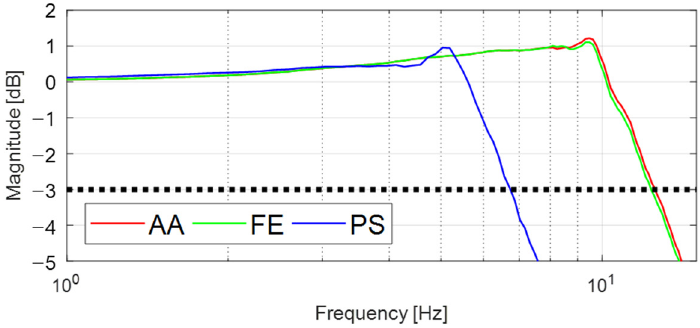
Figure 8. Frequency responses of the proposed device for each DOF from simulation.